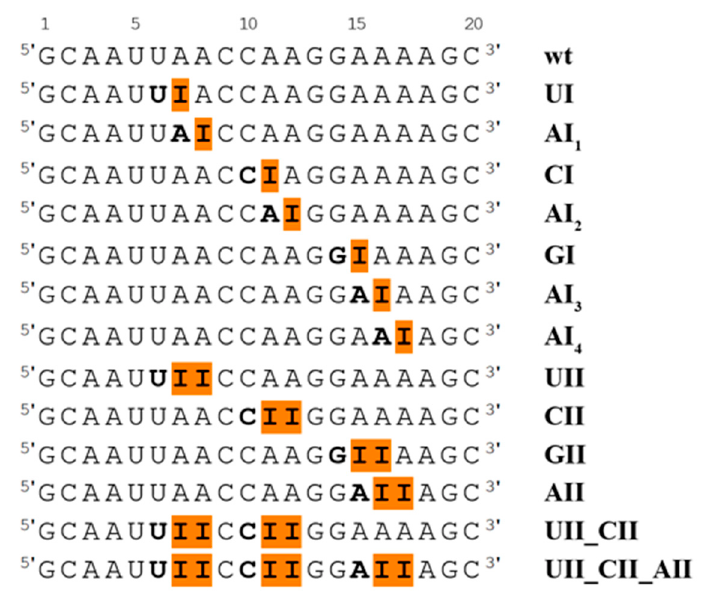
Figure 1. Summary of all duplexes simulated in this study presented as a sequence of the first strand. Inosines are highlighted by orange boxes, and the sequence used for simulation naming is in bold.